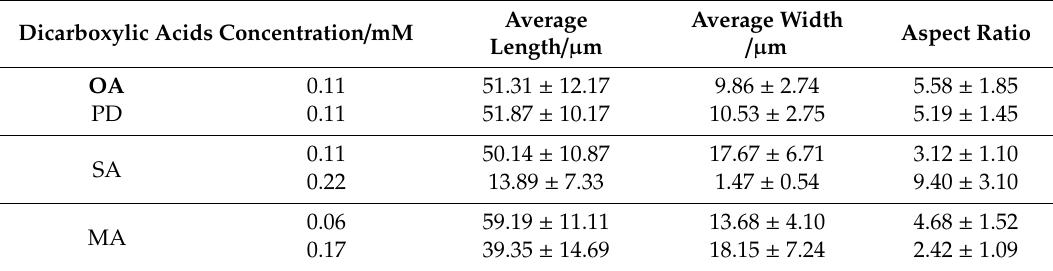
Figure 10. Effect of straight-chain dicarboxylic acid on the crystal habit of CaSO 4 ·0.5H 2 O. ( a ) OA: 0.11 mM; ( b ) PD: 0.11 mM; ( c ) SA: 0.11 mM; ( d ) SA: 0.22 mM; ( e ) MA: 0.06 mM; ( f ): MA: 0.17 mM. Table 3. Effect of straight-chain dicarboxylic acid on the length, diameter, and aspect ratio of α -CaSO 4 ·0.5H 2 O particles.